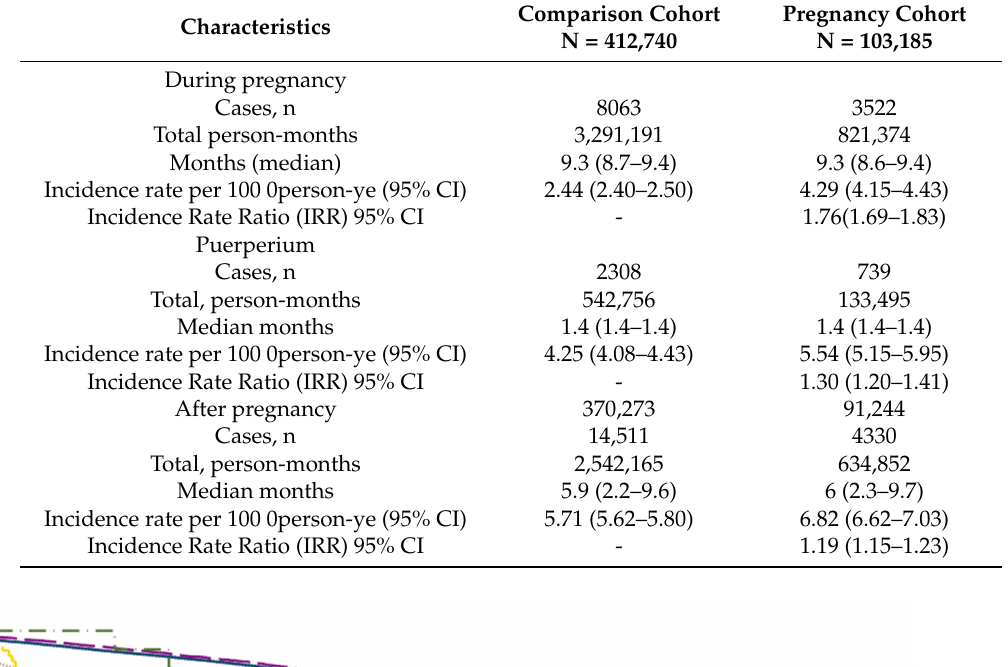
Table 1. Incidence rates of COVID restricted to women during pregnancy and their pairs (i.e., excluding women infected during puerperium or after pregnancy).